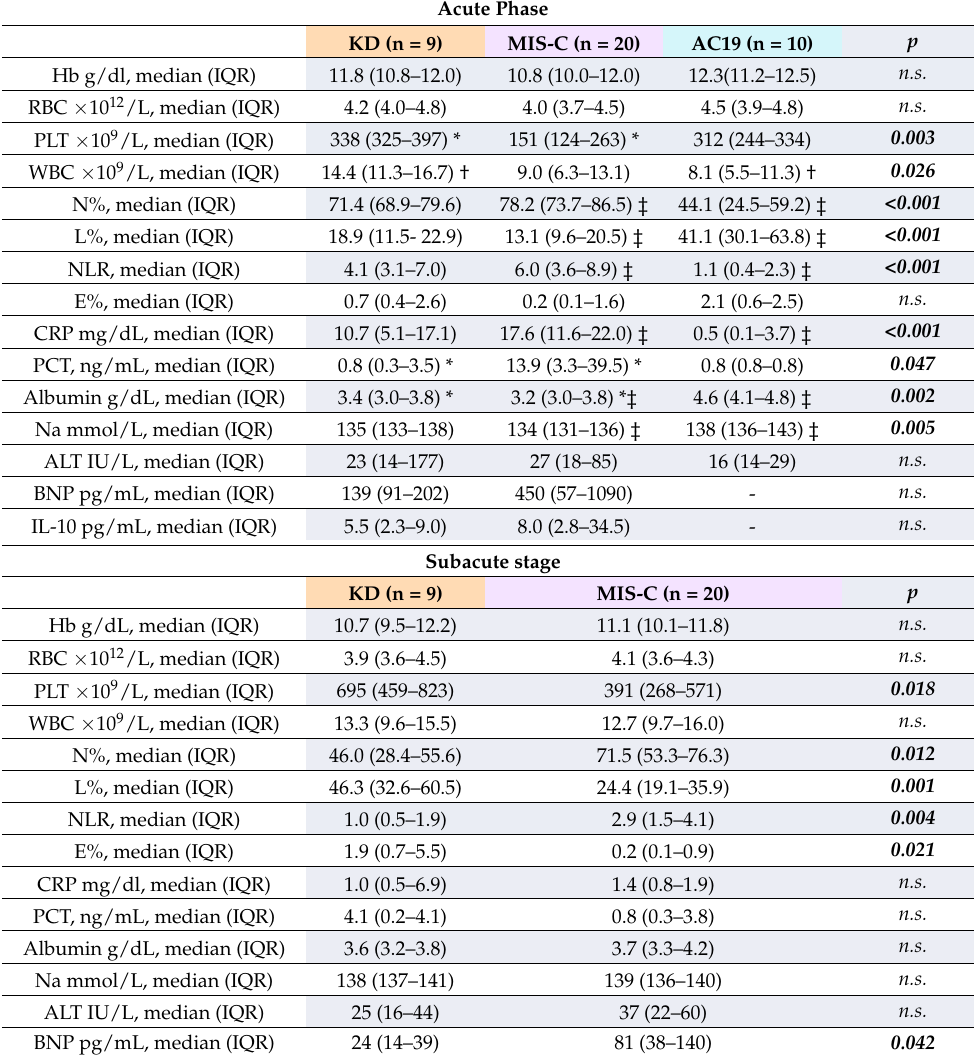
Table 3. Laboratory values during the acute and subacute phases of children diagnosed with KD, MIS-C and